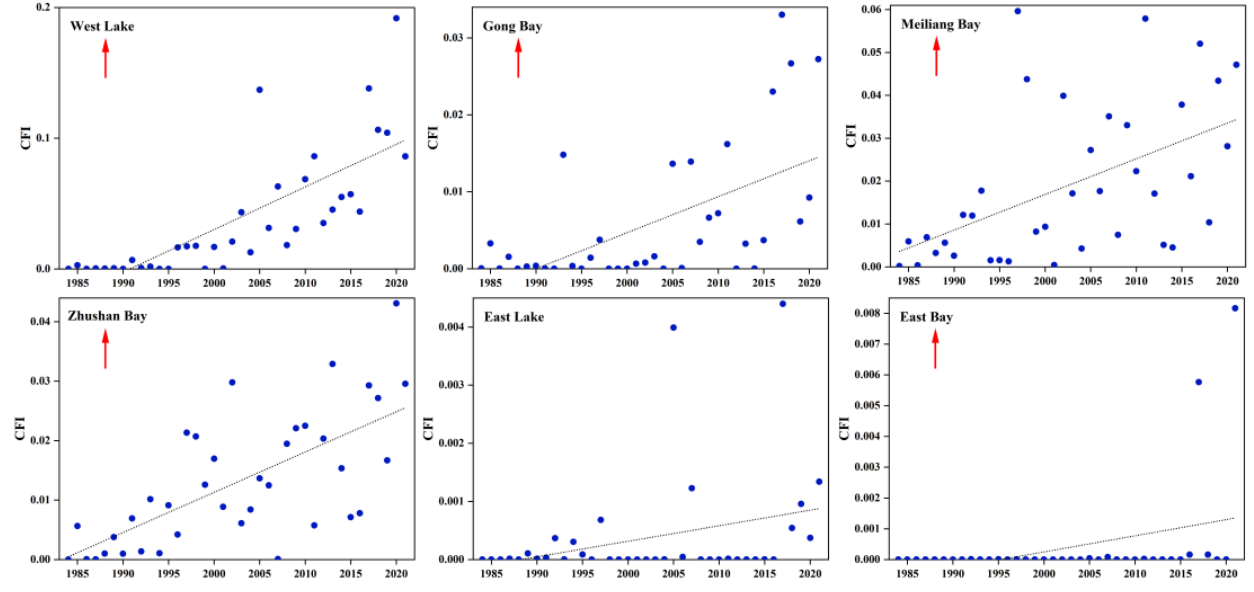
Figure 8. Annual cyanobacterial bloom frequency for the entire lake and each segment. The arrows indicate that the CFI values showed a significant ( p < 0.05) increasing trend over 38 years.